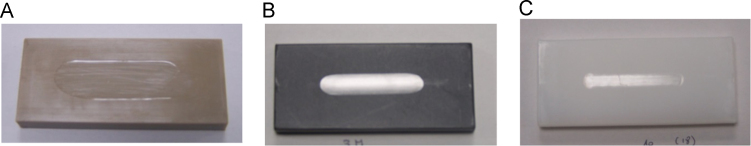
Comparison of wear scars on polymer plates after 1Mc (A: PEEK, B: CFR-PEEK, C: UHMWPE).